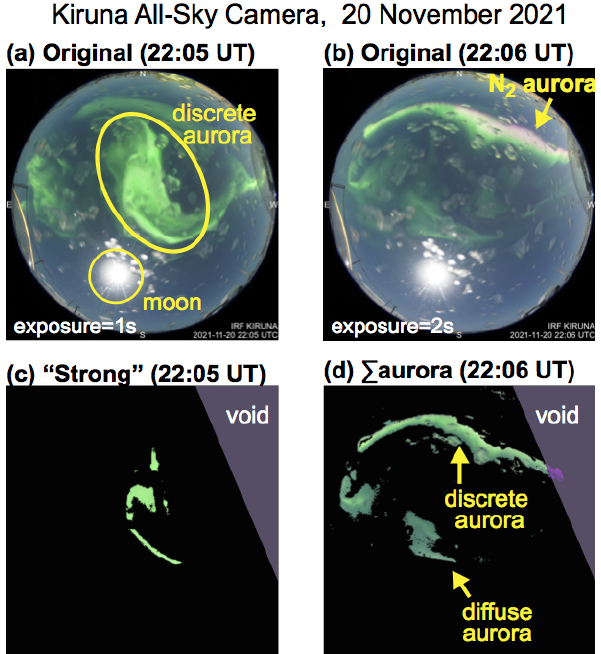
Figure 4. All-sky images of 20 November 2021 at (a) 22:05UT with 1s exposure and (b) 22:06UT with 2s exposure, in the same format as in Fig. 1a. (c, d) Processed images of (a) and (b) in the same format as in Fig. 1c and 1b, respectively. The bright spot is the Moon, which is removed during the